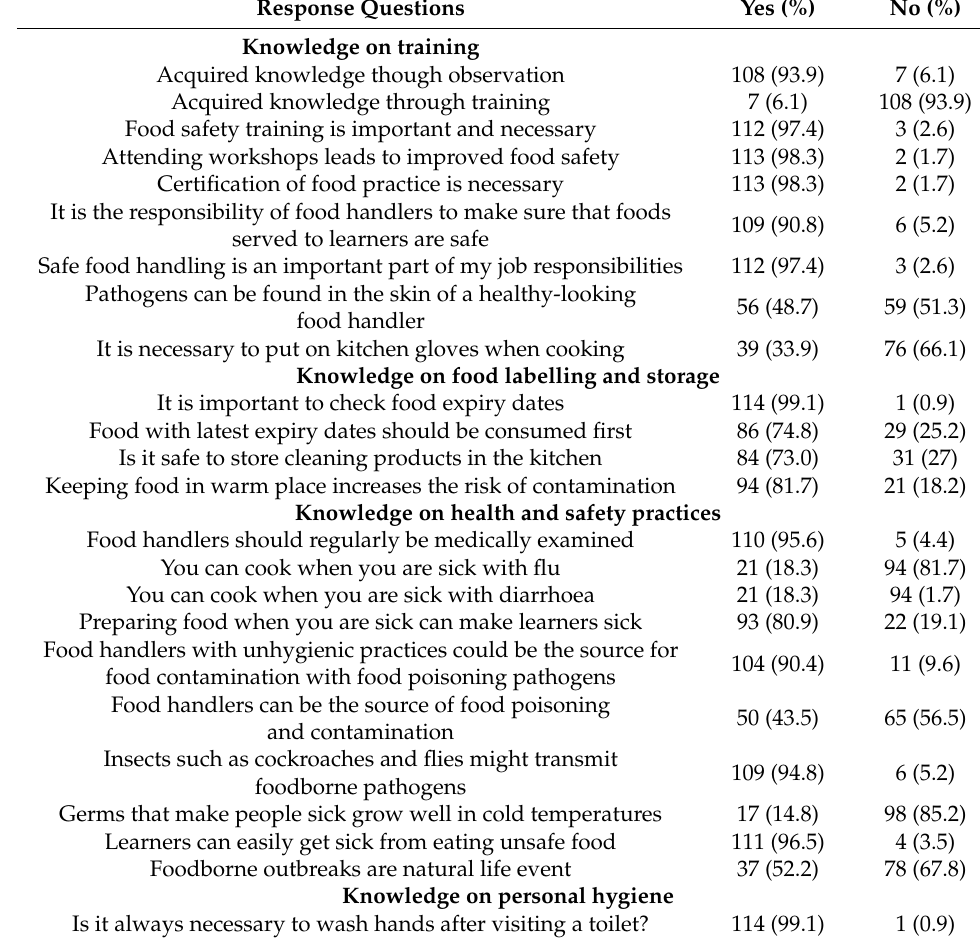
Table 2. Volunteer food handlers’ knowledge on food